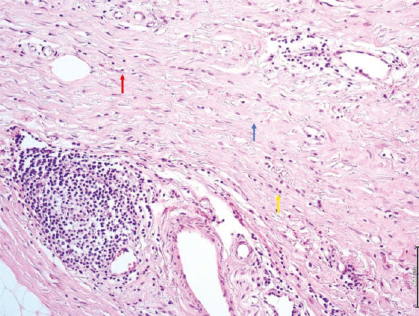
Figure 5: Stromal cells (blue arrow), tumor cells (yellow arrow), and lymphocytes (red arrow) on a fibrous background after neoadjuvant therapy (x200; H δ